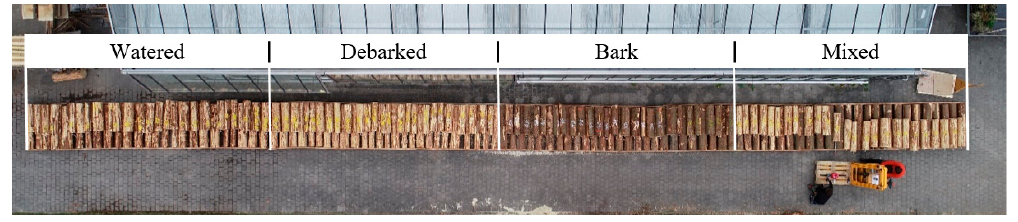
Figure 1. Top view of the test setup containing 100 test logs (1.0 m in length) lying on a row of support logs (1.5 m in length), divided into four treatments.